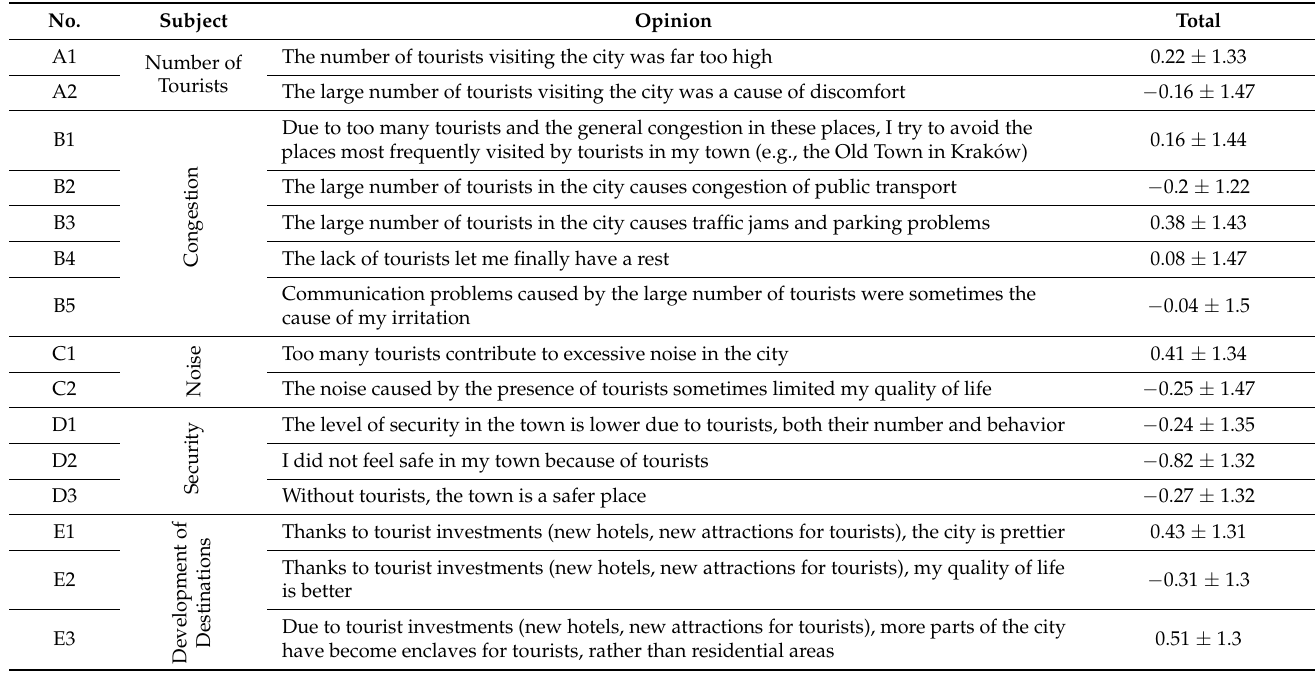
Table 1. Opinions that diagnose the respondents’ attitudes to tourists and average rank